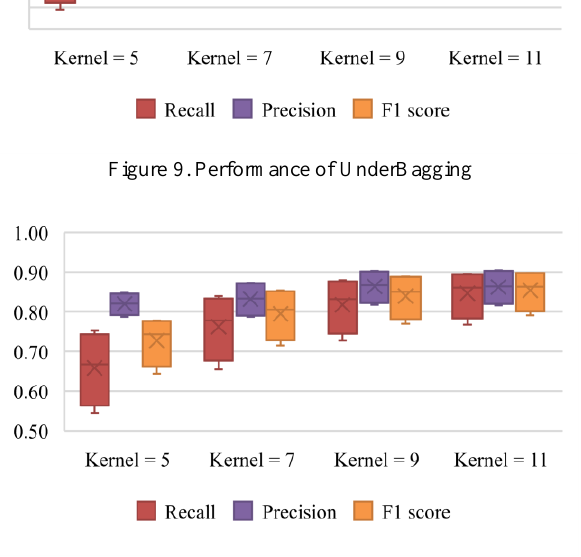
Figure 10. Performance of SMOTEBagging